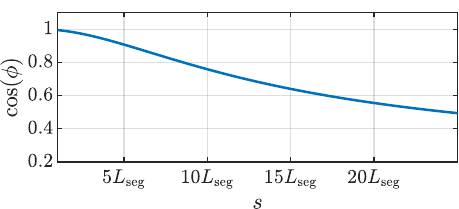
Figure 2. Theoretical characteristic of the linear motor power factor in relation to segment